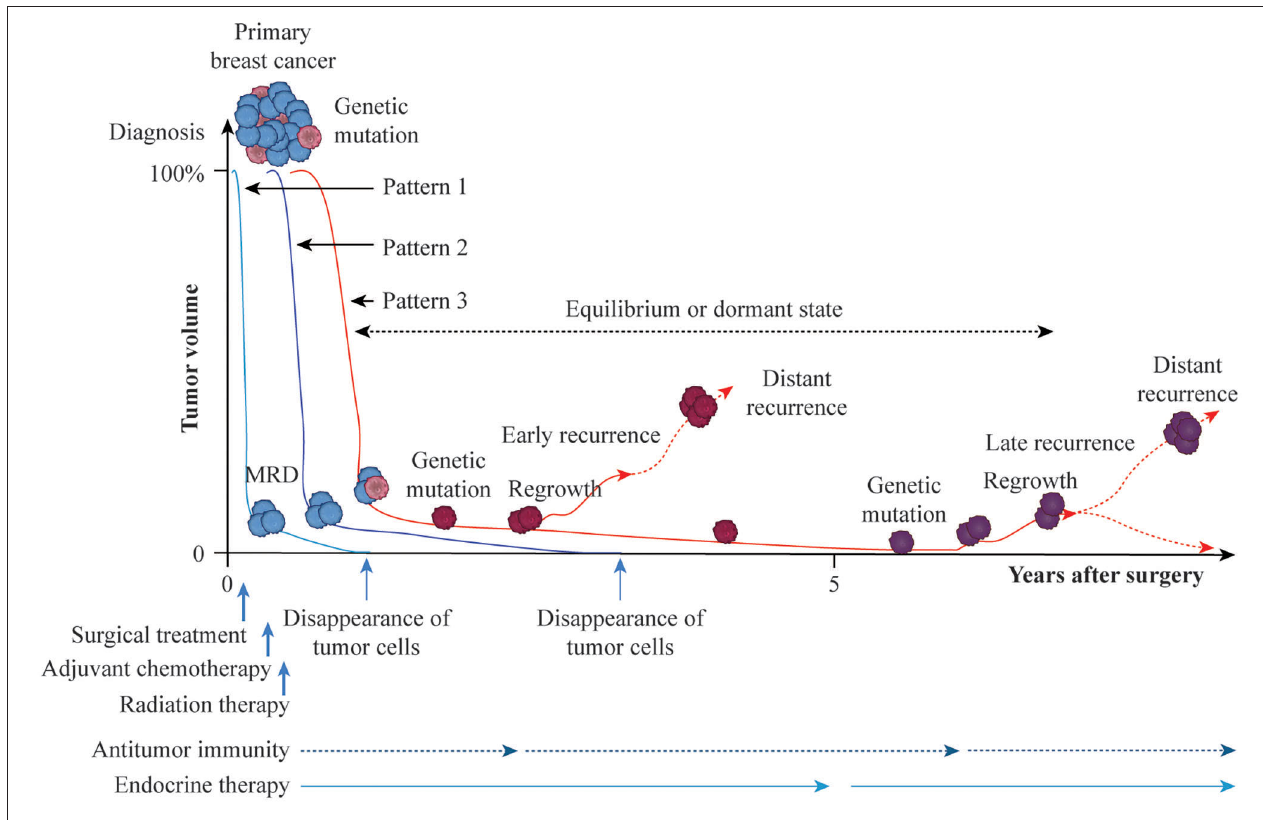
FIGURE 1 | Possible time courses leading to breast cancer cure or recurrence with distant metastasis after adjuvant therapy. Breast cancer is a heterogeneous population with genetic mutations. Surgical treatment reduces the primary tumor volume at diagnosis, arbitrarily set to 100%, and axillary lymph-node metastasis to near 0% macroscopically. Then, adjuvant and radiation treatments are administered to eradicate putative residual tumor cells at the microscopic or molecular level (MRD, minimal residual disease). If adjuvant therapy is successful against residual tumor cells without genetic mutations, breast cancer is cured by the cytotoxic effects of anticancer agents, cytostatic effect of endocrine therapy, or induction of antitumor immunity (Pattern 1). Residual tumor cells without genetic mutations may persist for years in equilibrium or in a dormant state and then eventually disappear, leading to a cure (Pattern 2). Persistent residual tumor cells with genetic mutations are resistant to adjuvant therapy and may proliferate and cause distant metastasis as early recurrence with additional genetic mutations or remain in equilibrium or in a dormant state for several years, eventually disappearing, resulting in prolonged recurrence-free survival due to the effects of endocrine therapy or antitumor immunity. Otherwise, regrown tumor cells may cause distant metastasis as late recurrence with further genetic mutations (Patten